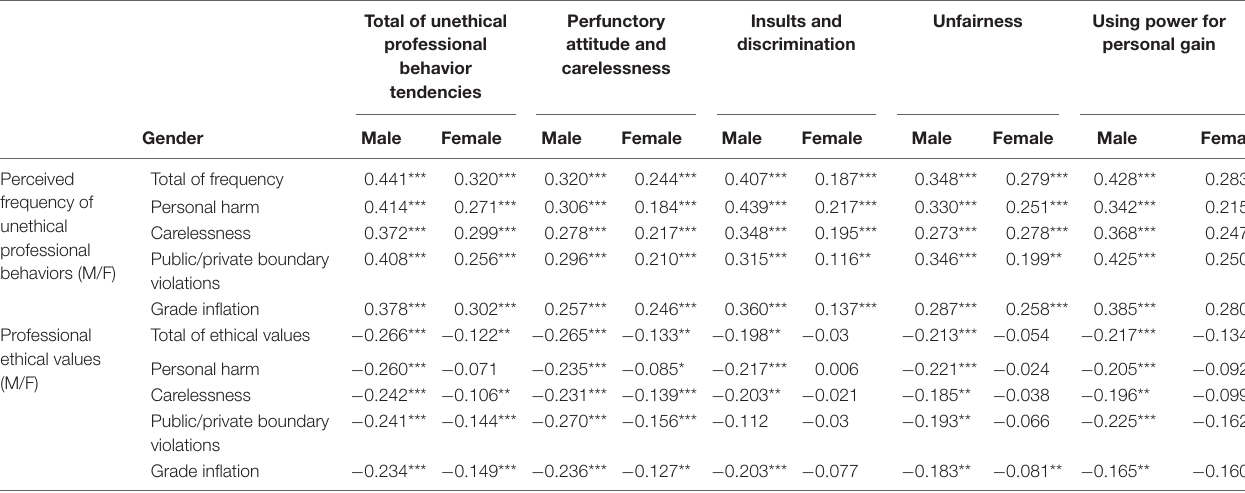
TABLE 9 | Correlations between student teachers’ unethical professional behavior tendencies, professional ethical values, and perceived frequency of unethical professional behaviors (Analysis based on male and female